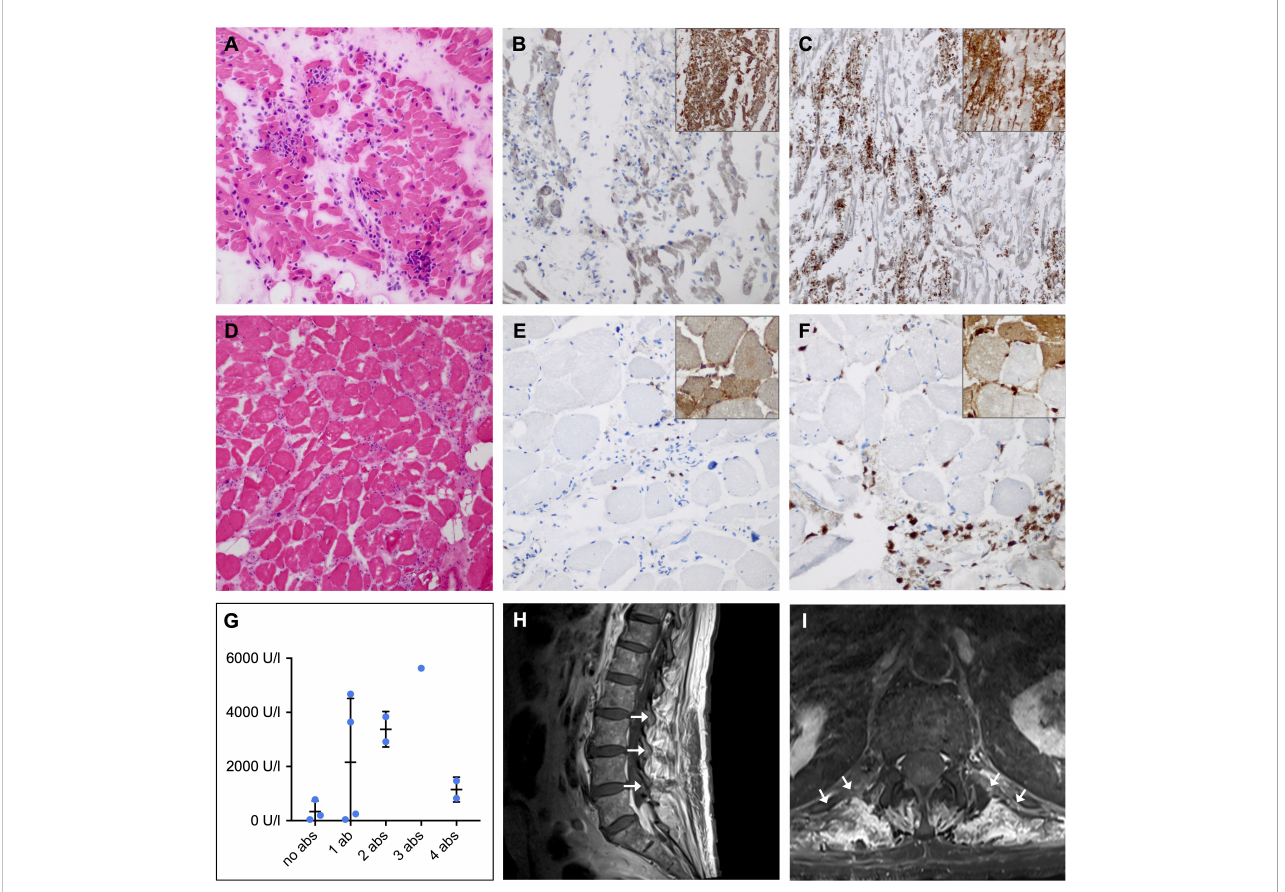
FIGURE 3 Histopathological and clinical fi ndings in patients with ICI-induced myositis. (A-F) Hematoxylin-eosin (HE) and immunohistochemical staining in a female patient with fatal ICI-induced myositis and myocarditis and positive anti-titin, anti-heart muscle and anti-skeletal muscle autoantibodies. Frozen sections of HE-stained (A) cardiac muscle (D) and skeletal muscle showing necrotic myo fi bers and lymphocyte in fi ltration (original magni fi cation x 100). CD8 (large panel, original magni fi cation x 200) and major histocompatibility complex (MHC) class I (inset, original magni fi cation x 100) staining revealing cytotoxic T cell invasion and sarcolemmal overexpression of MHC class I by (B) cardiac and (E) skeletal muscle fi bers. CD68 (large panel, original magni fi cation x 200) and MHC class II (inset, original magni fi cation x 100) staining showing macrophage invasion and sarcolemmal as well as sarcoplasmic overexpression of MHC class II by (C) cardiac and (F) skeletal muscle fi bers. (G) Comparison of peripheral blood creatine kinase (CK) levels in patients with ICI-induced myositis shows a trend towards higher CK levels in patients with multiple neuromuscular autoantibodies compared to patients without neuromuscular autoantibodies. (H) Sagittal and (I) axial contrast-enhanced magnetic resonance imaging of the lumbar spine with T1- weighted turbo spin echo sequence showing paravertebral contrast enhancement ( arrows ) as a sign of muscle edema in a patient with ICI-induced myositis and myasthenia. Ab, autoantibody; ICI, immune checkpoint inhibitor; U/l, units per